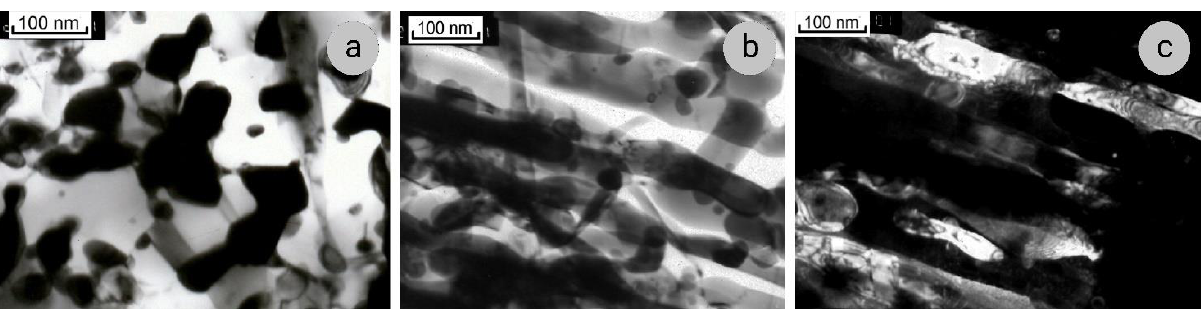
Figure 8. TEM images of Sample 2 ( e = 12.5) annealed at 600 ° С, 1 h: ( a ) — transverse section; ( b , с ) — longitudinal sections; c dark-field image in (110) Nb and (111) Cu reflections.